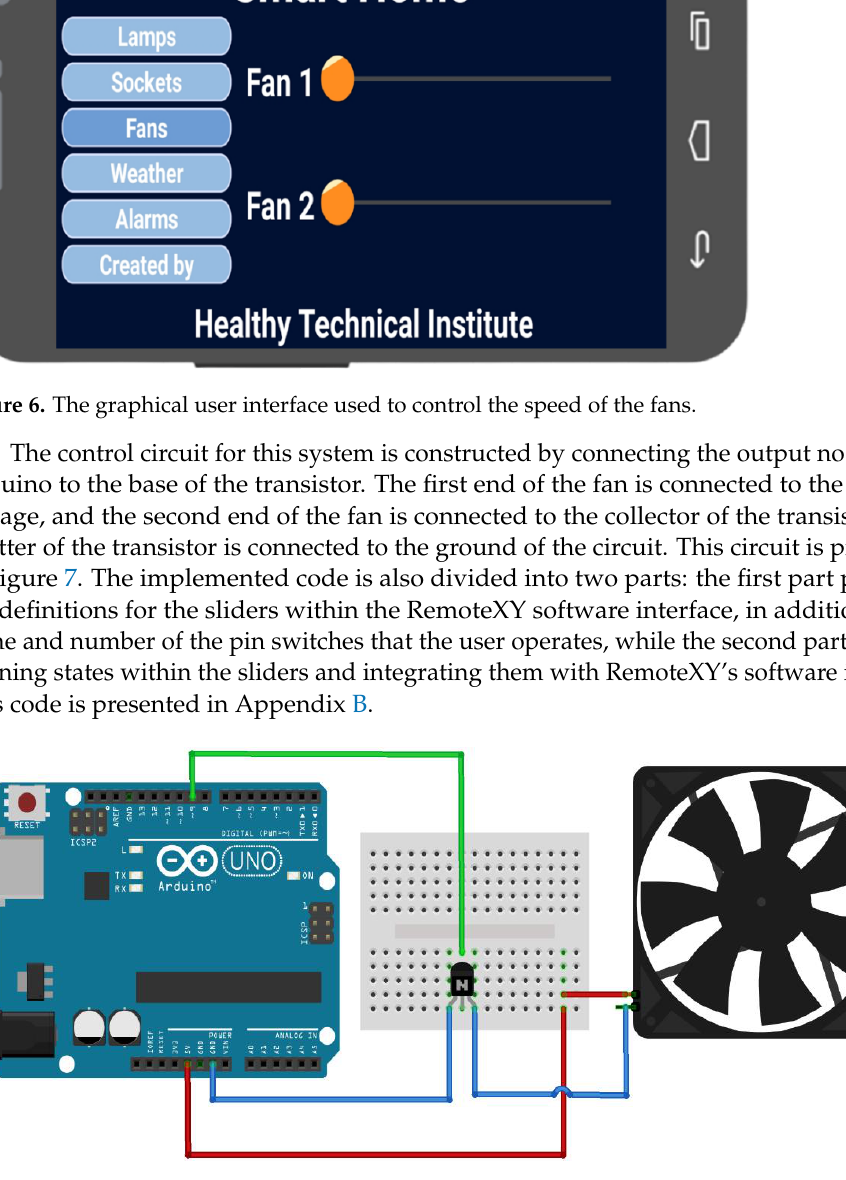
Table 3. The main components used to control the fan speed.